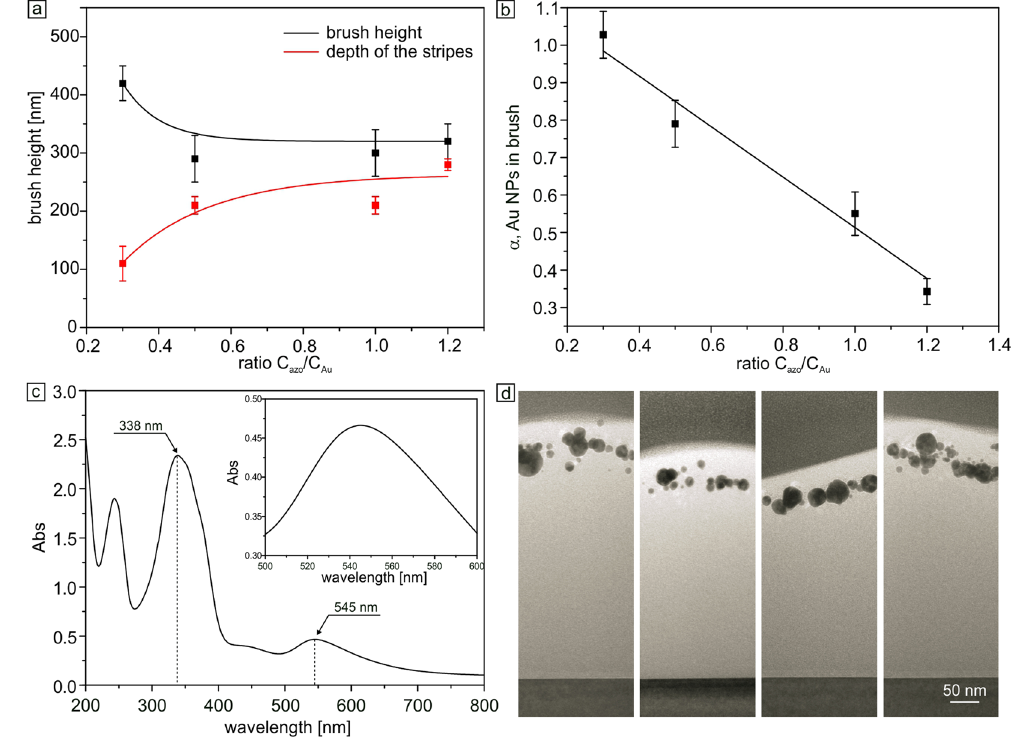
Figure 2. ( a ) Dependence of the height of the PMAA brush after absorption of azo-AuNPs, as a function of C azo /C Au ratio (black curve). The red curve shows the height of the nano-wires produced from the brushes in ( b ). ( b ) Dependence of the amount of gold nanoparticles within the brush as a function of C azo /C Au . ( c ) Absorption spectrum of the PMAA brush loaded with azo-AuNPs. The inset depicts a surface plasmon peak of the gold aggregates at λ = 545 nm. ( d ) TEM cross sectional images of the brush film obtained by cutting it using a